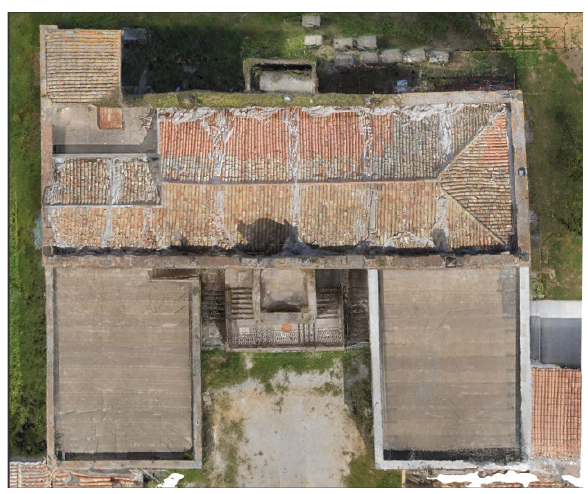
Figure 18. Nadiral ortho-image.